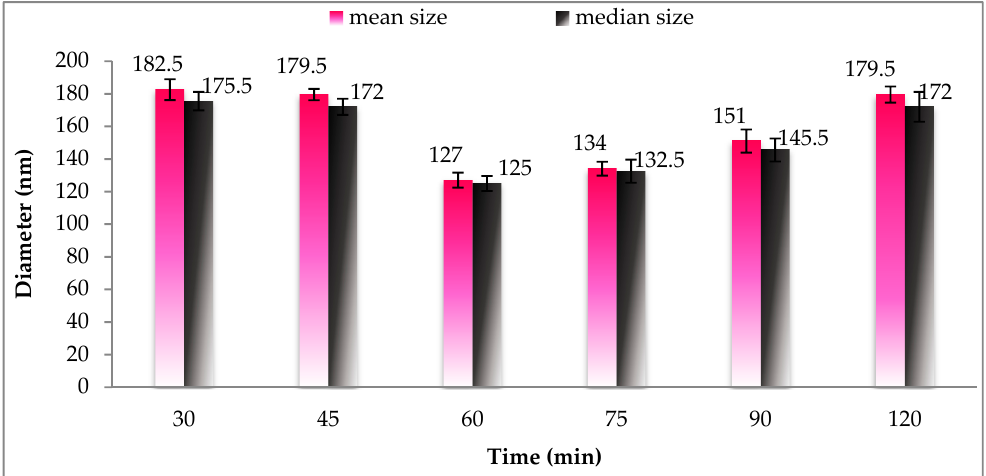
Figure 2. Size distribution of gac oil-loaded SLNs at different times of hot homogenization.